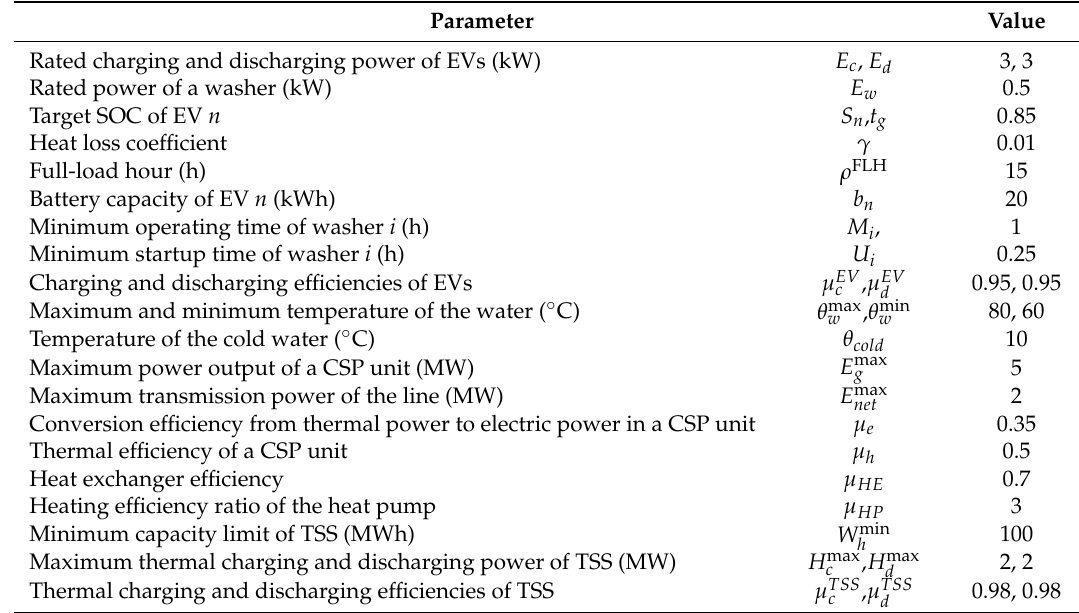
Table 2. Parameter